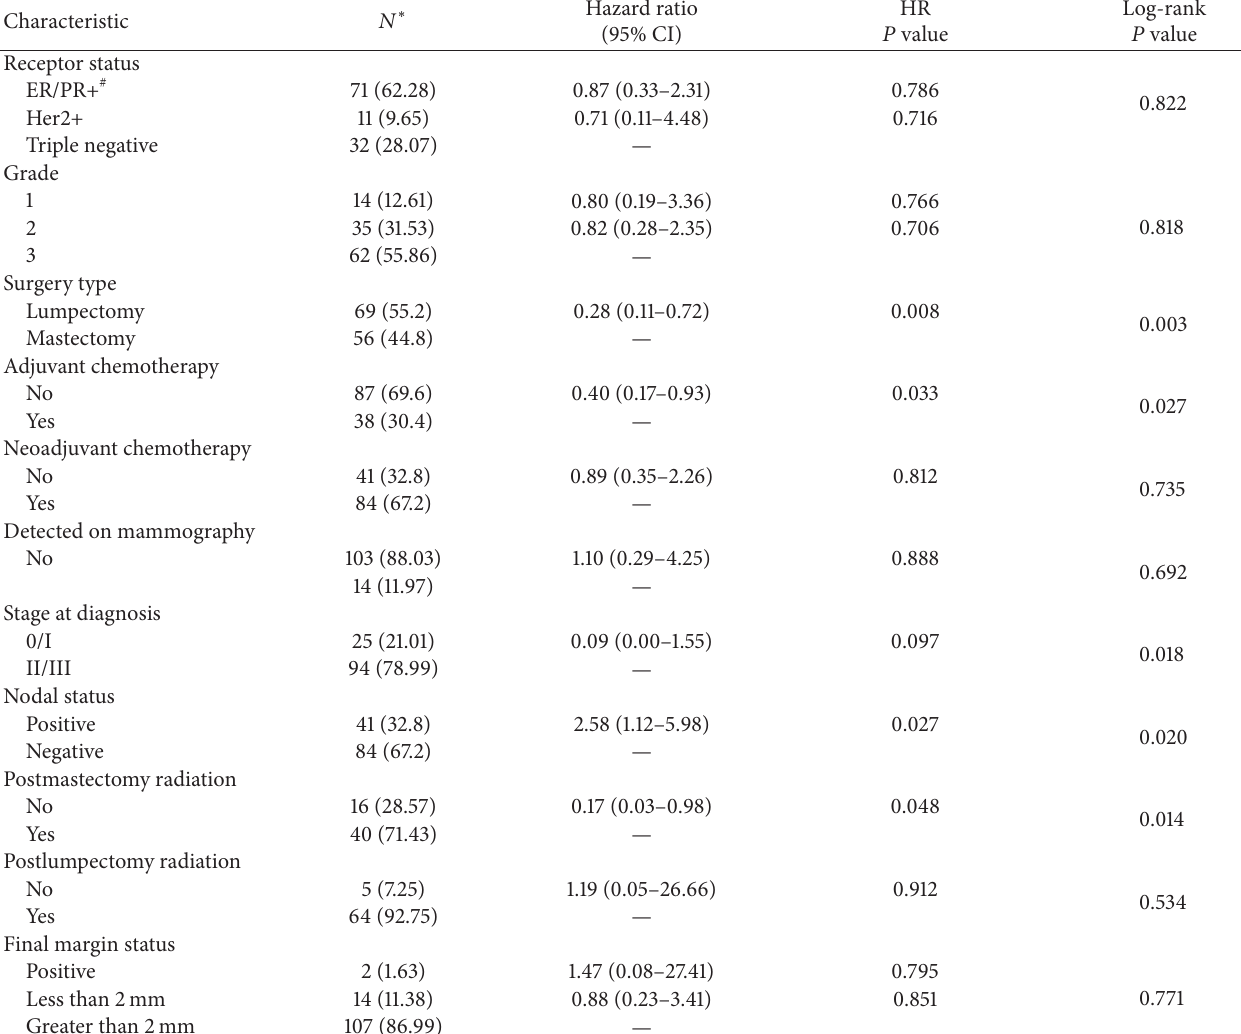
Table 3: Univariate analysis of risk factors for distant recurrence-free survival in younger women.